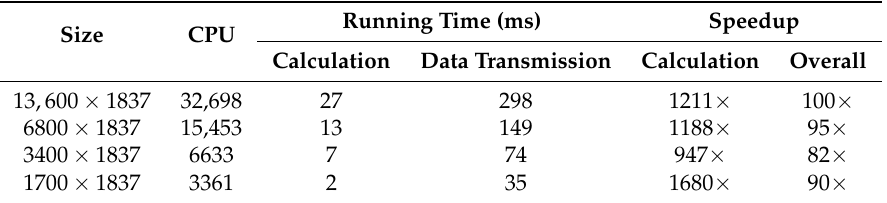
Table 3. Acceleration results of Oh inversion.